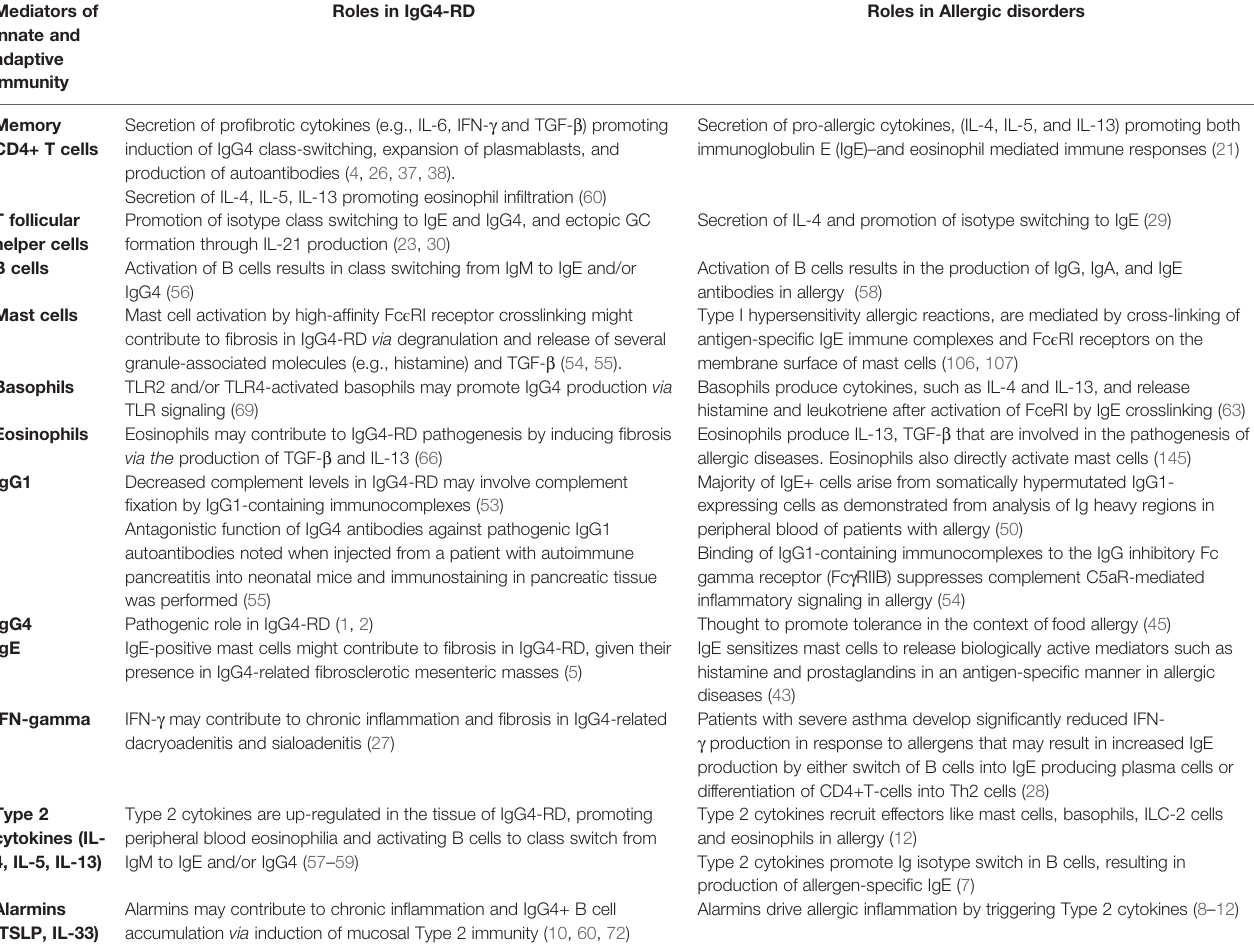
TABLE 1 | Mediators of innate and adaptive immunity in IgG4-RD and allergic disorders. Roles in IgG4-RD Roles in Allergic